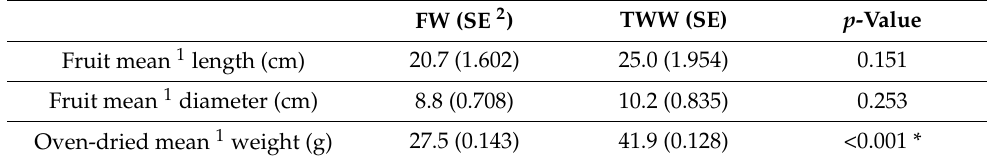
Table 2. Mean values of fruit length, diameter and oven-dried weight of the used TWW and FW. FW (SE 2 ) TWW (SE) p -Value Fruit mean 1 length